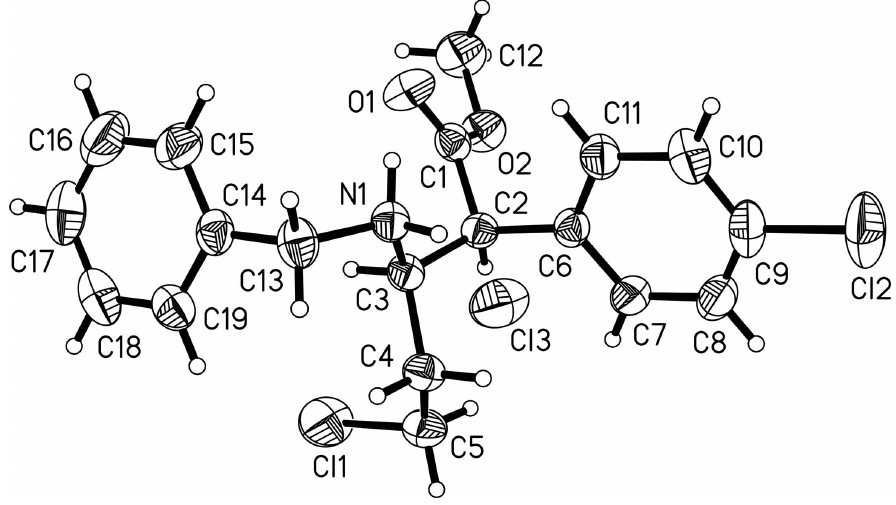
Figure 1 The molecular structure of (I). Displacement ellipsoids are shown at the 50% probability level and H-atoms are shown as spheres of arbitrary